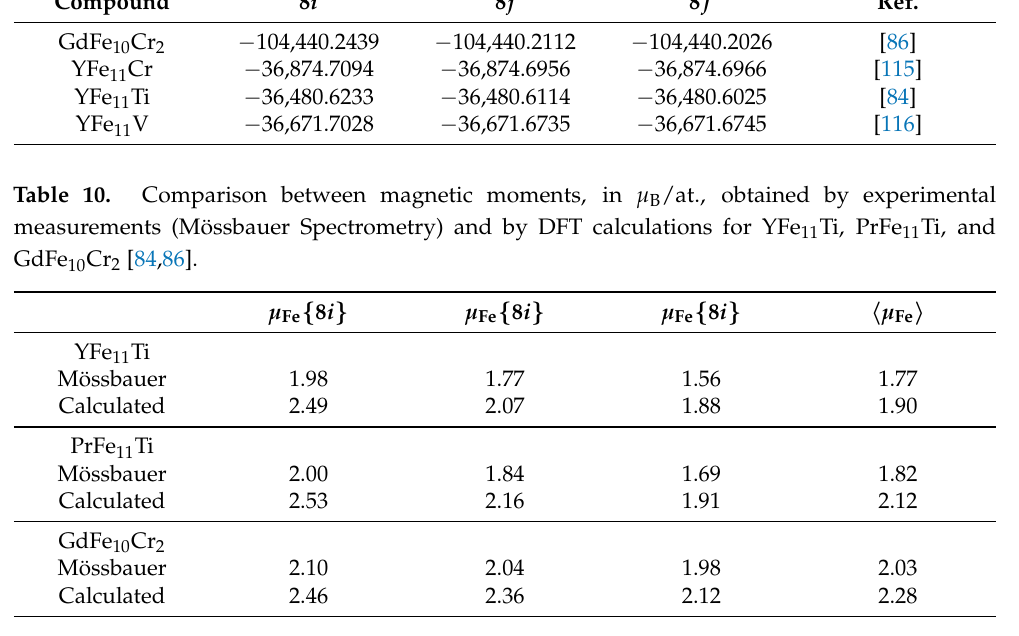
Table 9. Calculated energy E (Ry) of GdFe 10 Cr 2 , YFe 11 Cr, YFe 11 Ti, and YFe 11 V with Cr, Ti, and V atoms occupying different sites. Compound 8 i 8 j 8 f Ref.